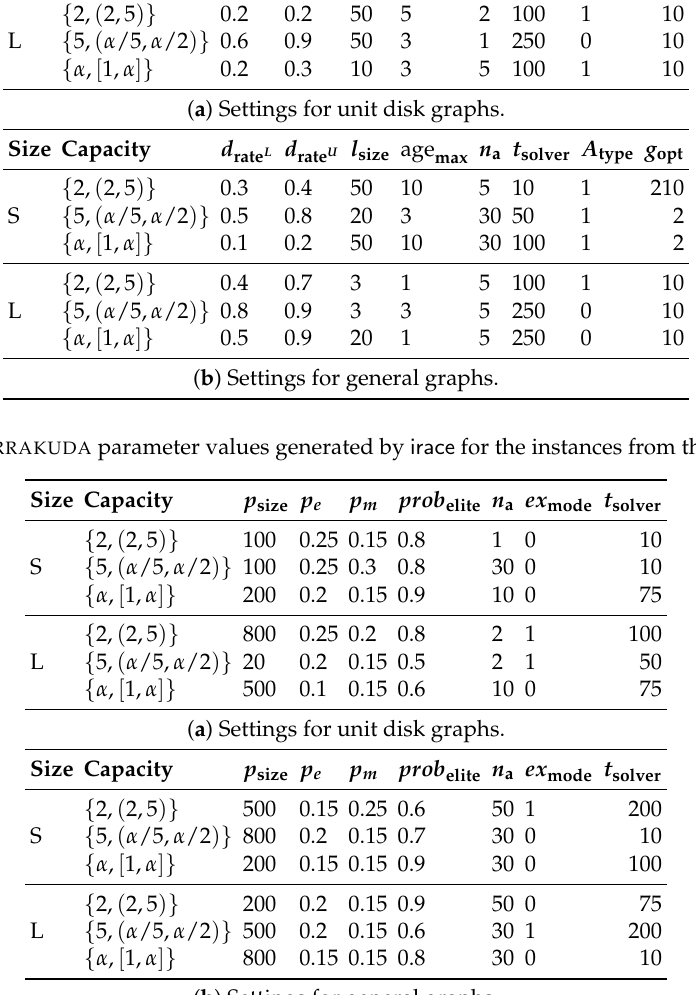
( b ) Settings for general